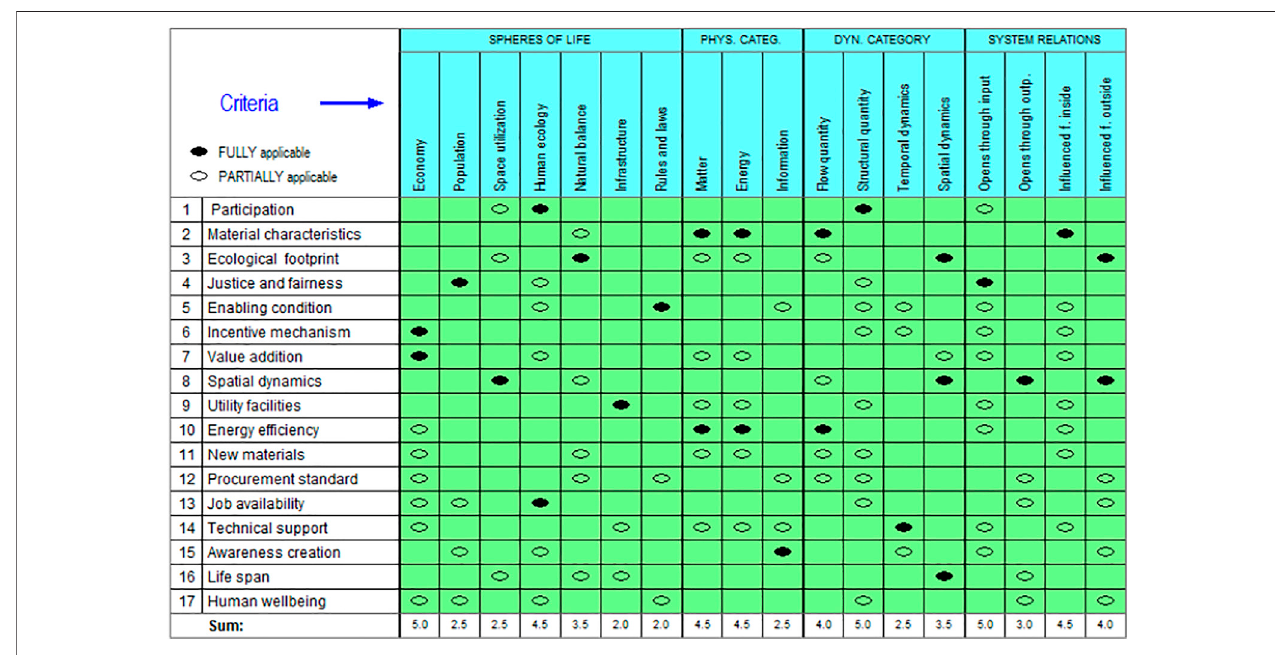
FIGURE 1 | Variable relevance